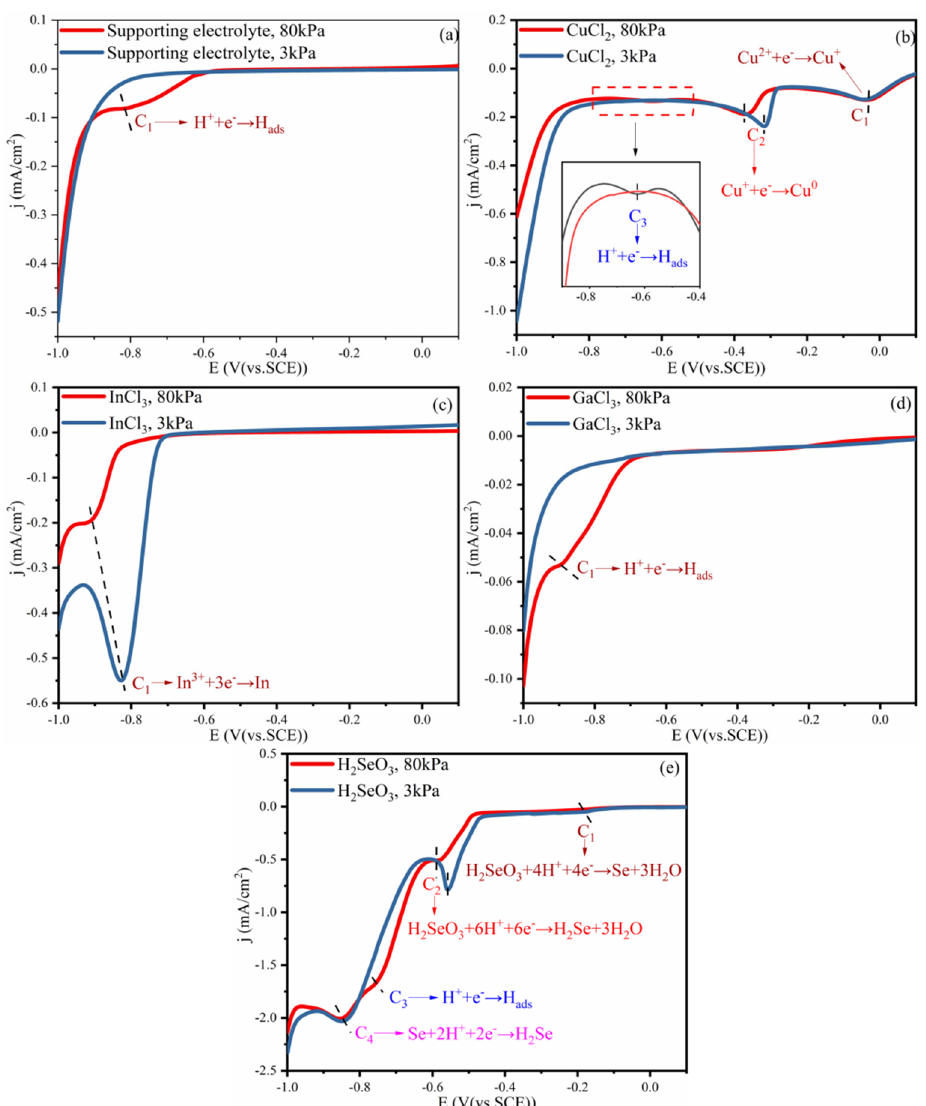
Figure 3. The LSV curves in the ( a ) supporting electrolyte, ( b ) 4 mM CuCl 2 , ( c ) 10 mM InCl 3 , ( d ) 10 mM GaCl 3 , and ( e ) 8 mM H 2 SeO 3 unary solutions at 3 kPa.